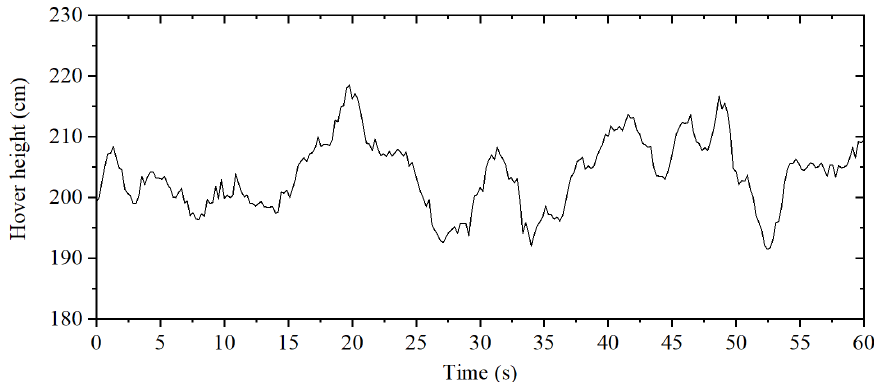
Figure 17. Change of hovering height of dual-arm manipulator when it is stationary.